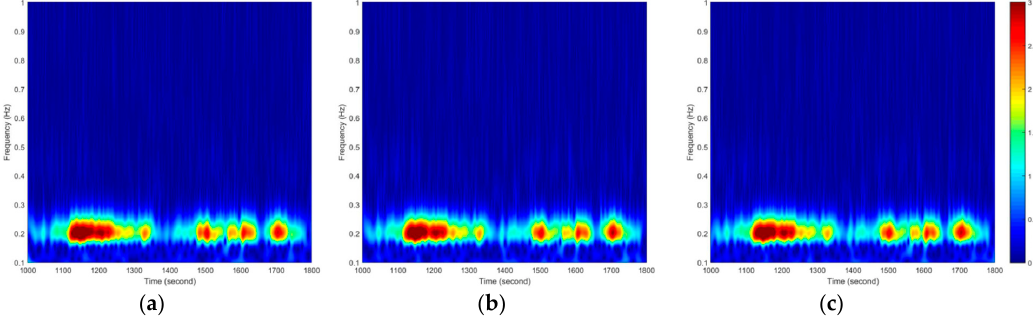
Figure 10. Spectrum of GPS displacement time history (0~1 Hz band) in the X direction: ( a ) relative positioning method, ( b ) combining high- and low-rate GPS method, and ( c ) PPP method.